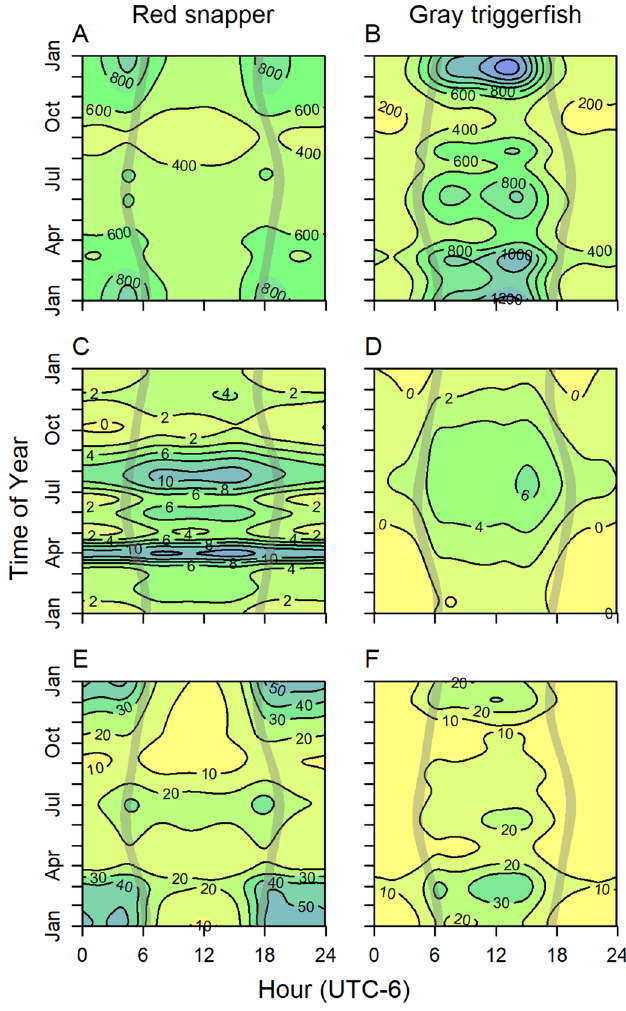
Figure 4. GAMM predicted hourly home range (m 2 ; A , B ), height above bottom (m, C , D ), and distance to reef (m, E , F ) of red snapper and gray triggerfish as a function of time of day and time of year. Overshaded areas represent dawn and